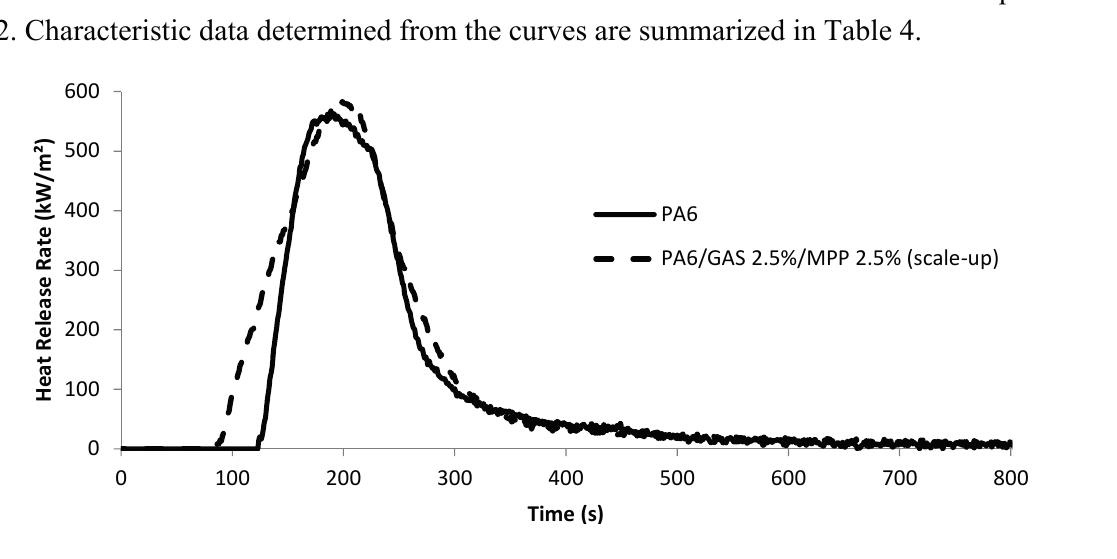
Figure 2. Cone calorimetry curves of PA6 and the PA6/GAS 2.5%/MPP 2.5% formulation extruded at a large scale (35 kW/m 2 , 25 mm). Table 4. Cone calorimetry data of PA6 and the PA6/GAS 2.5%/MPP 2.5%